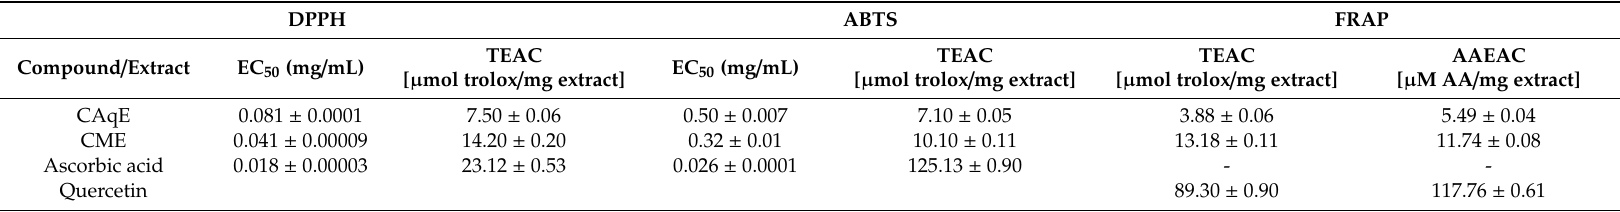
Table 3. TEAC values for the DPPH, ABTS and FRAP